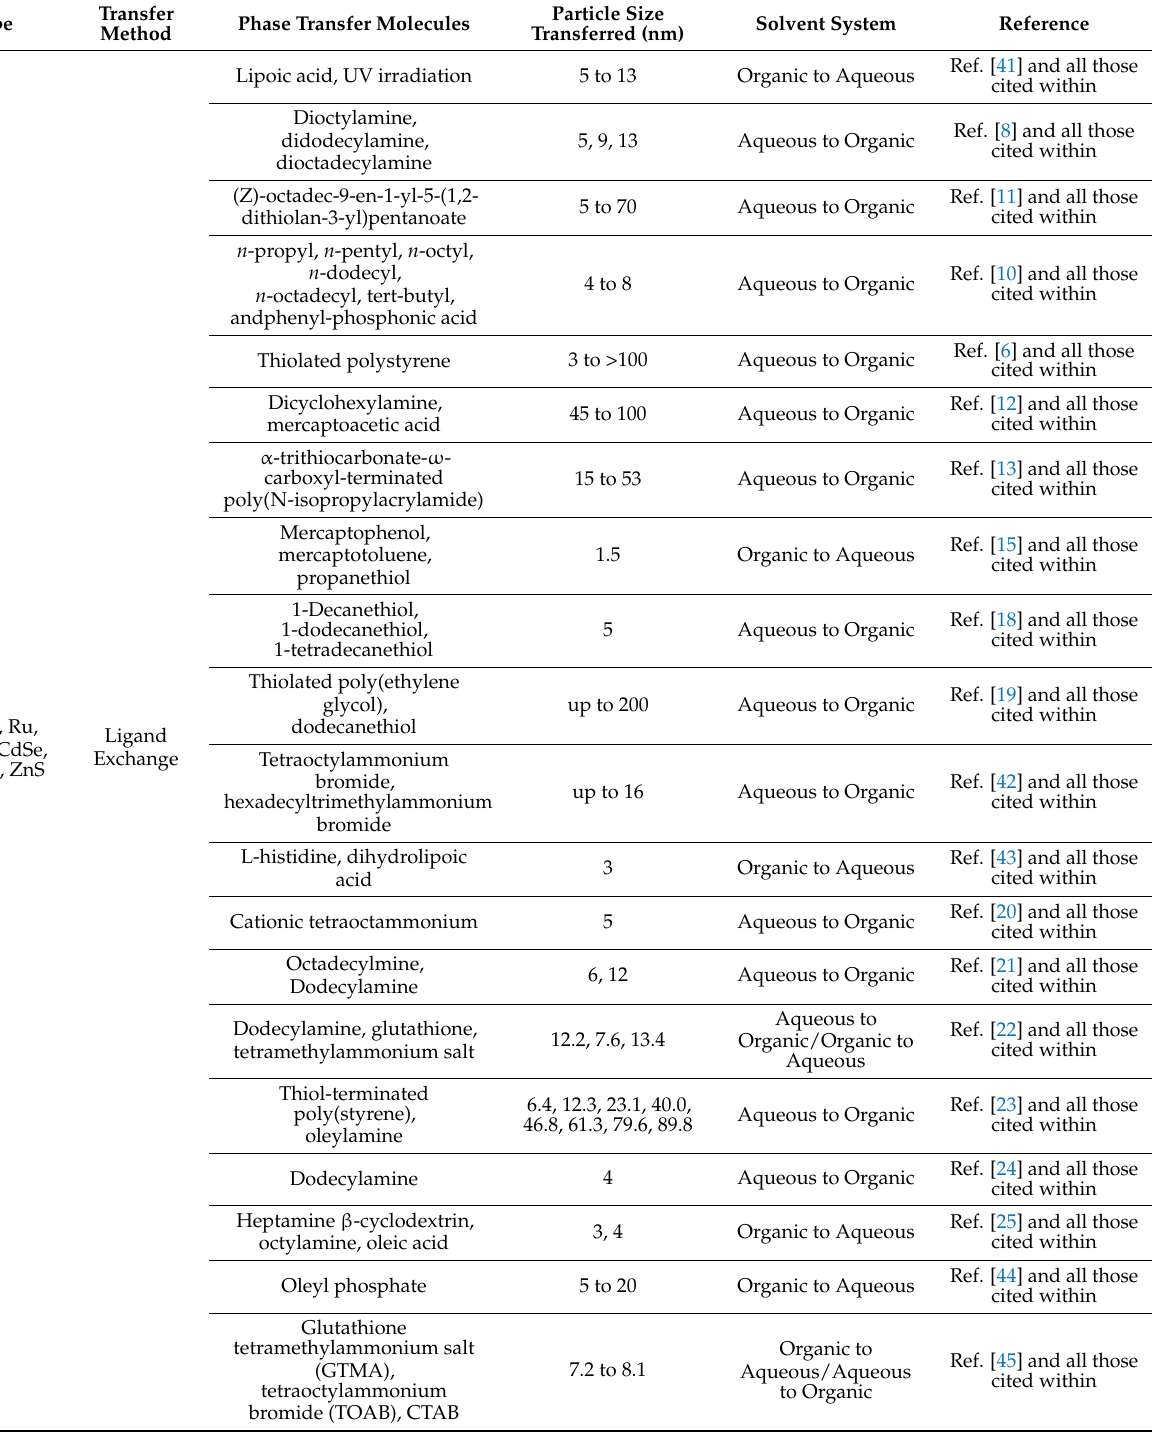
Table 1. Representative methods for phase transfer summarized in this